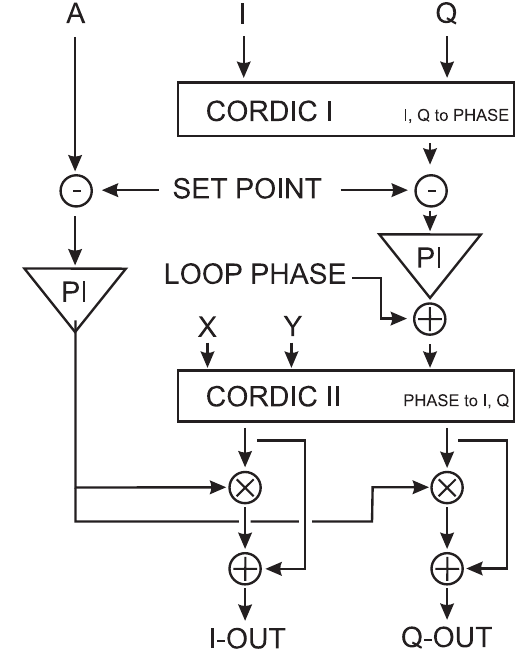
FIG. 7. Diagram of the new